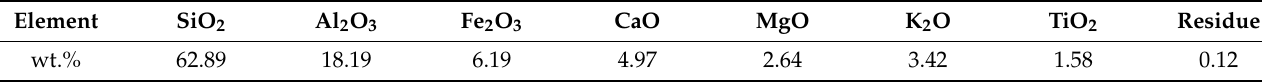
Table 2. Composition of granite waste powder (wt.%).